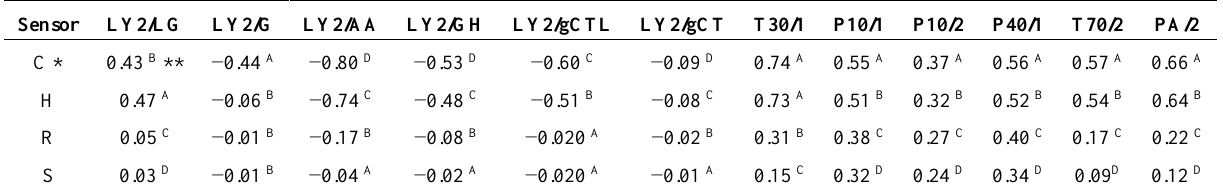
Table 3. ANOVA of e-nose maximum resistance ratio (MRR) values for four oil samples. Sensor